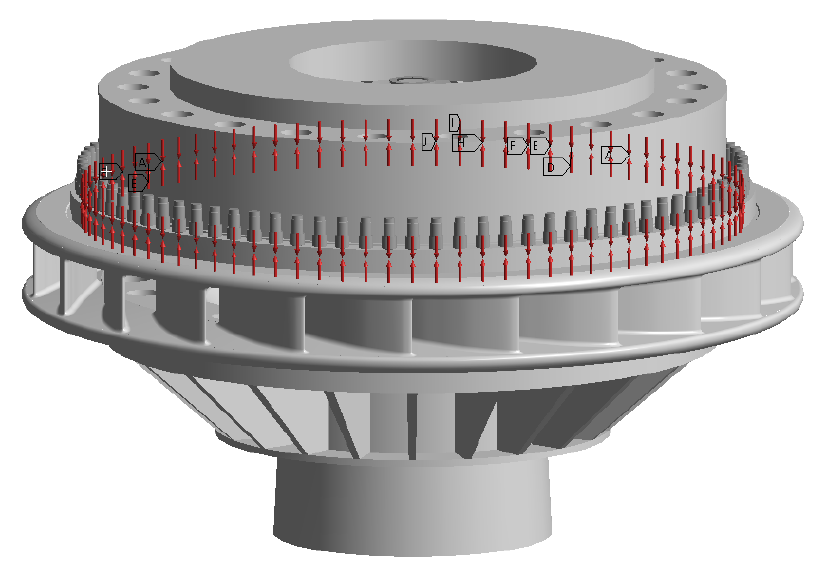
Figure 13. Preload applied on the head-cover bolts. When the water flows in the fluid channel, the high water pressure acts on the inner surfaces of the head-cover and the stay ring, etc., so the head-cover bolts connecting the head-cover and the stay ring start to bear the large hydraulic forces. During the turbine start-up transient process, the large hydraulic forces changed dramatically with time due to the unsteady flow in the PT unit. The pressure loads calculated by the CFD at the key time points during the turbine start-up are exported as time series files, including the coordinates and the pressure value of each node of the fluid domain. The meshes for fluid and structural calculations are created separately, so the fluid mesh and the structural mesh on the FSC interface are usually different. With the built-in tool of ANSYS Mechanical, the nodal pressure loads can be effectively and accurately interpolated and mapped on the nearest structural nodes based on their coordinate values. As shown in Figure 14, the calculated pressure distributions during turbine start-up are sequentially transferred and mapped on the finite element model of the structural components, including head-cover, stay ring, and bottom ring, to calculate the structural deformations and stresses.